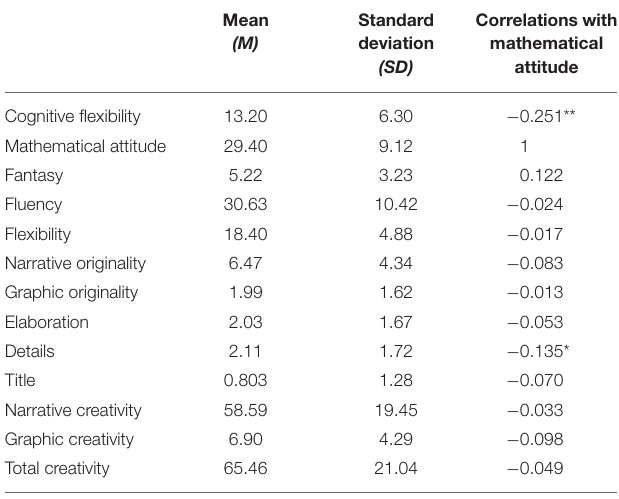
TABLE 1 | Mean (M) and SD for cognitive flexibility, mathematical attitude, creativity, and matrix correlation.